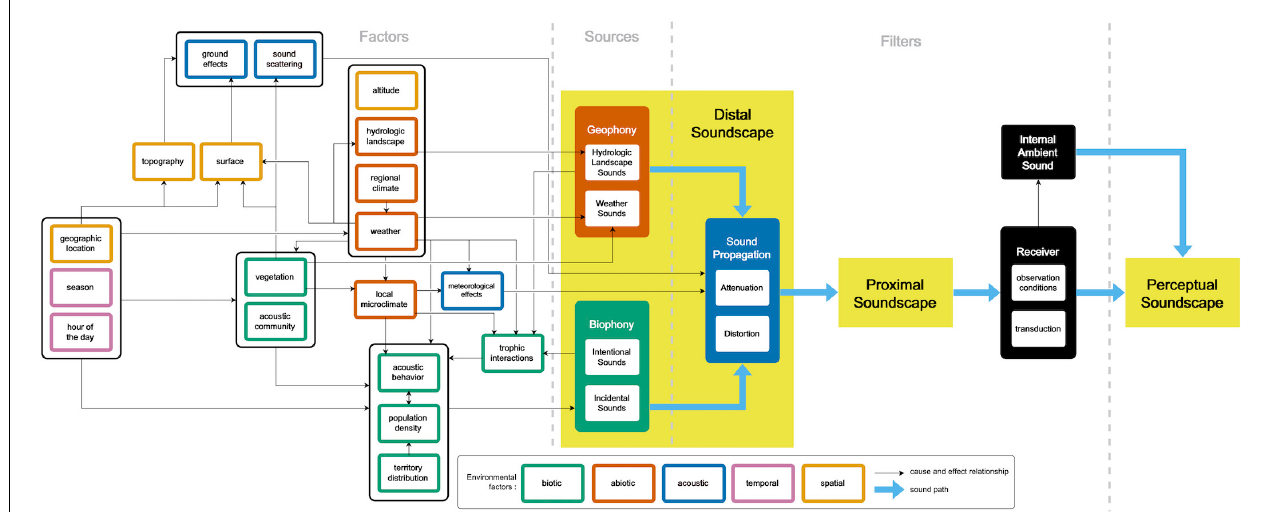
FIGURE 6 | Detailed soundscape functional block diagram. The complex entanglement of the different types of environmental factors reveals the underlying complexity of soundscapes. This diagram can be used as a graphical display of current soundscape related knowledge, or as a tool to evaluate the potential impact of environmental change on non-anthropogenic terrestrial